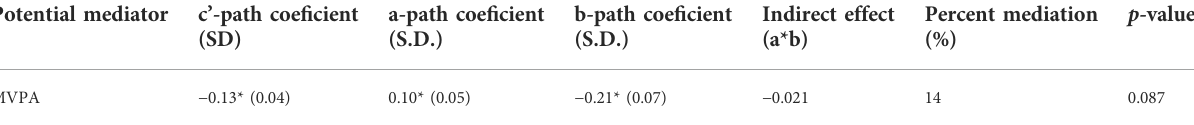
TABLE 4 Model of mediation by physical activity and association between neighborhood walkability and cognitive decline in older adults. EpiFloripa Aging Study. Florianópolis, Brazil, 2017 – 2019 (n = 1,162). Potential